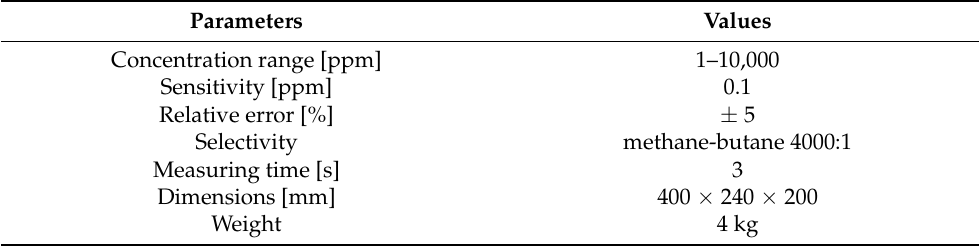
Table 2. The parameters of CIPS analyzer.